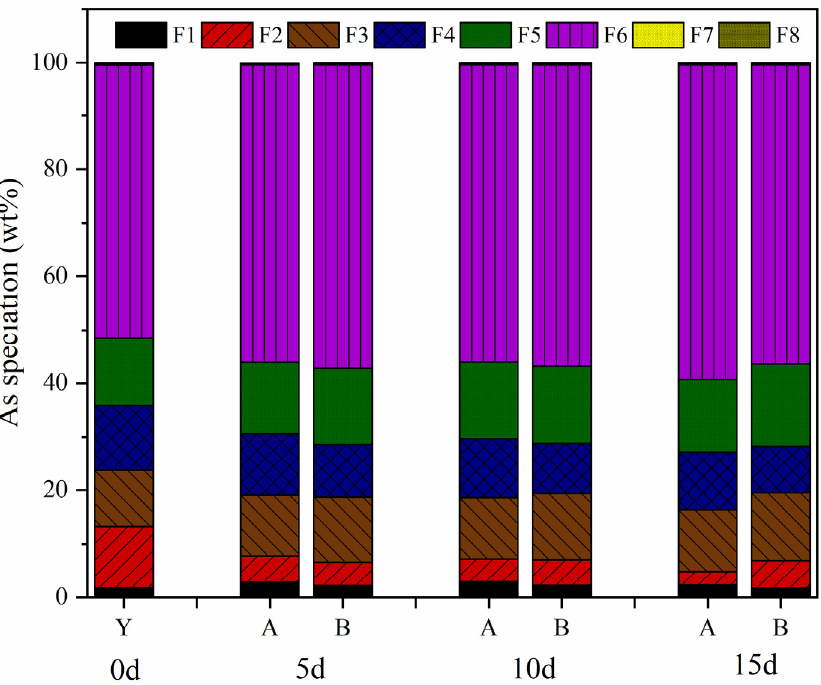
Figure 10. Determination of combined forms of arsenic by Keon continuous extraction method: ion-bound arsenic (F1); strongly adsorbed arsenic (F2); co-precipitated arsenic of minerals sensitive to low pH (F3); amorphous and weakly crystalline Fe(hydr)oxide bound arsenic (F4); crystalline Fe(hydr)oxide co-precipitated arsenic (F5); arsenic co-precipitated with oxides and silicates (F6); arsenic co-precipitated with pyrite and amorphous As 2 S 3 (F7); orpiment and remaining recalcitrant arsenic minerals (F8). Y: initial soil; A: Soil + Desulfovibrio vulgaris + 0 mM sulfate treatment; B: Soil + Desulfovibrio vulgaris + 1 mM sulfate